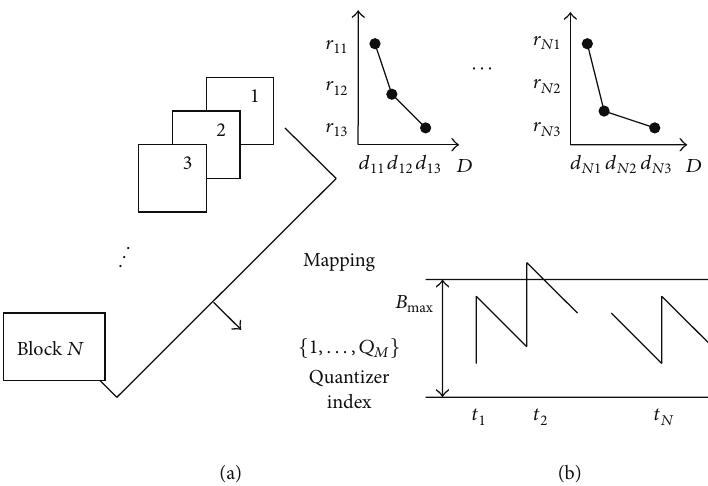
Figure 8: (a) Each block ( 1⋅⋅⋅𝑁 ) in the sequence has different R-D characteristics (for a given set of quantizers ( 1⋅⋅⋅𝑄 𝑀 ) for blocks in the sequence, R-D (rate-distortion) points ( 𝑟 𝑁1 , 𝑟 𝑁2 , 𝑟 𝑁3 and 𝑑 𝑁1 , 𝑑 𝑁2 , 𝑑 𝑁 , etc.) can be obtained to form composite characteristics); and (b) R at 𝑡 2 is not a feasible solution to the selected maximum buffer size